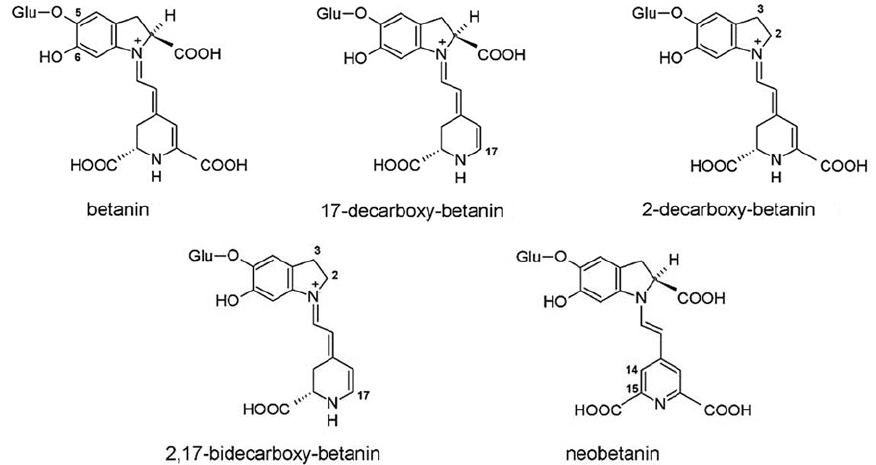
Figure 13. Structures of betacyanins investigated applying ABTS / PP assay [141]. Copyright 2013, adapted with permission from American Chemical Society.